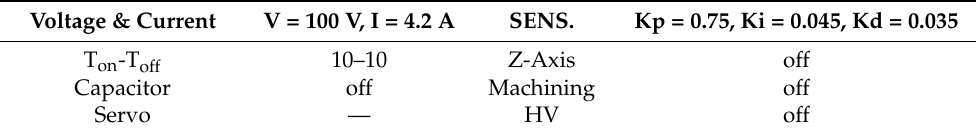
Table 2. Parameter settings of the micro-EDM.